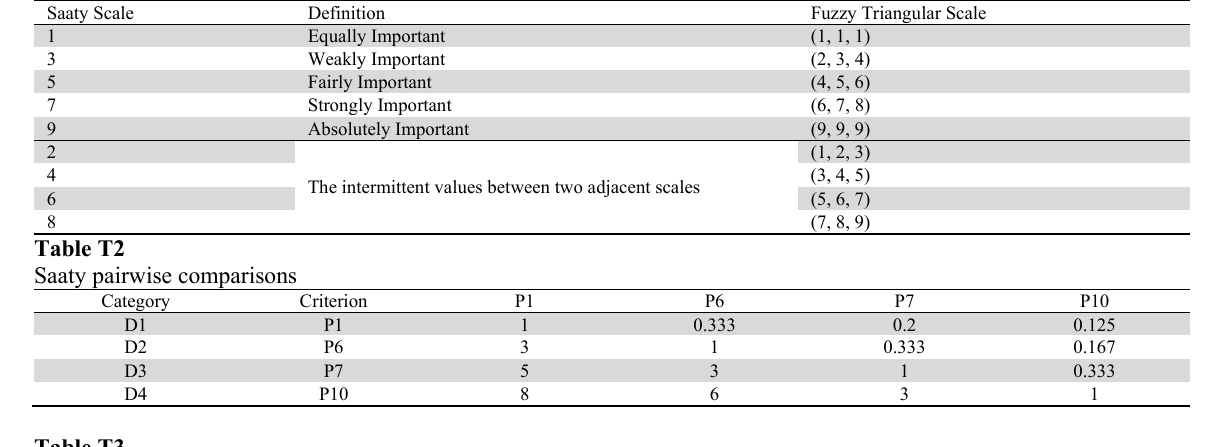
Fuzzy triangular comparisons Criterion